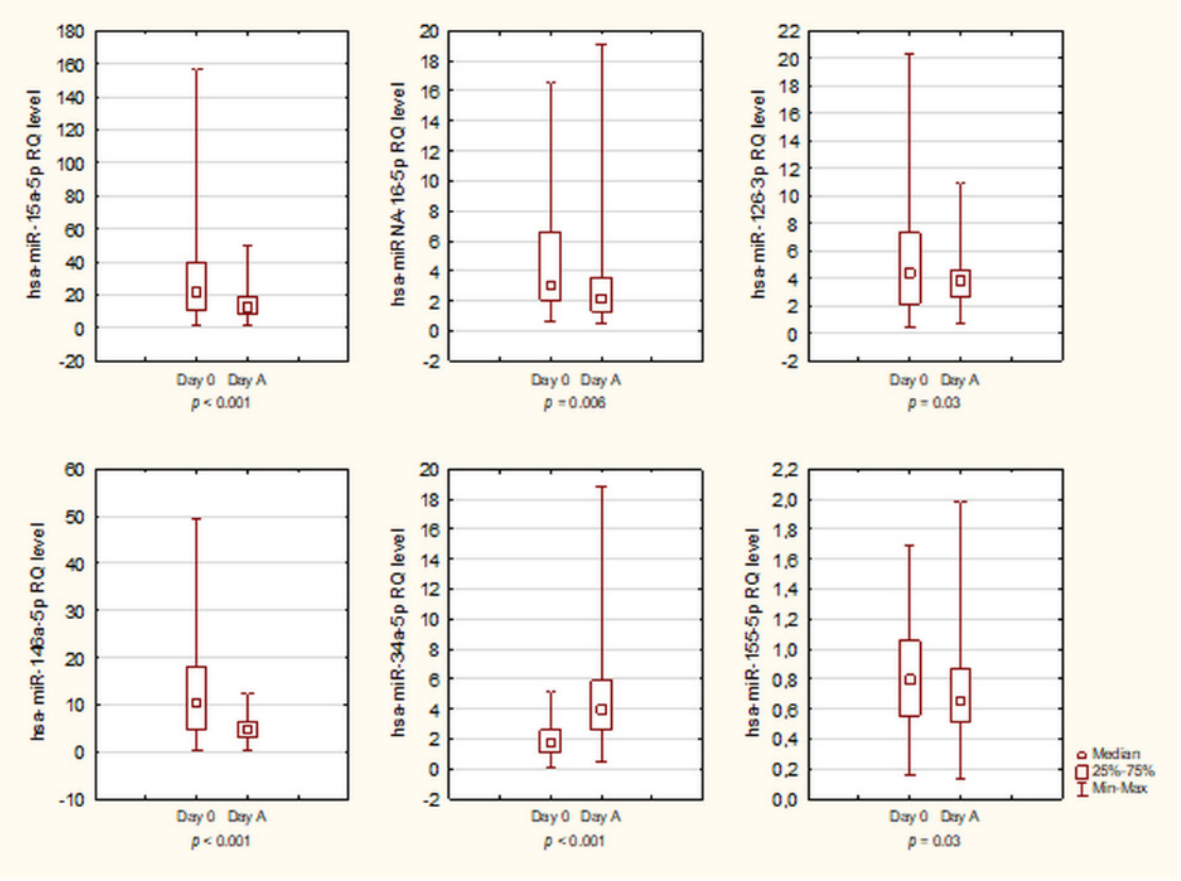
Figure 4. The kinetics of miRNAs expression at two time points: the day before HSC mobilization (day 0) and the day of the first apheresis (day A): hsa-miR-15a-5p, hsa-miR-16-5p, hsa-miR-126-3p, hsa-miR-146a-5p, hsa-miR-34a-5p, and hsa-miR-155-5p. Table 3. Changes in miRNA expression (RQ) before mobilization chemotherapy and on the day of the first apheresis.